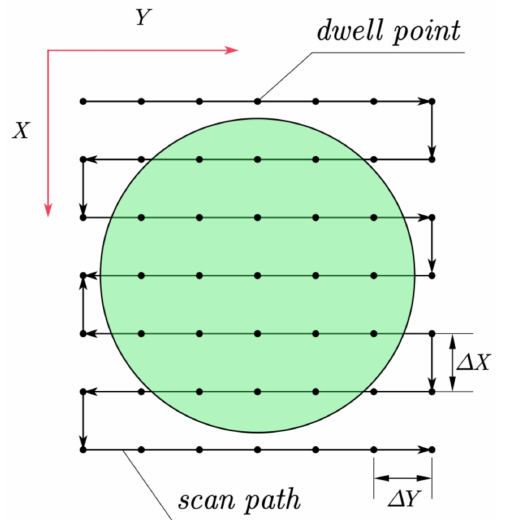
Figure 2. The grating scanning path for IBF processing.